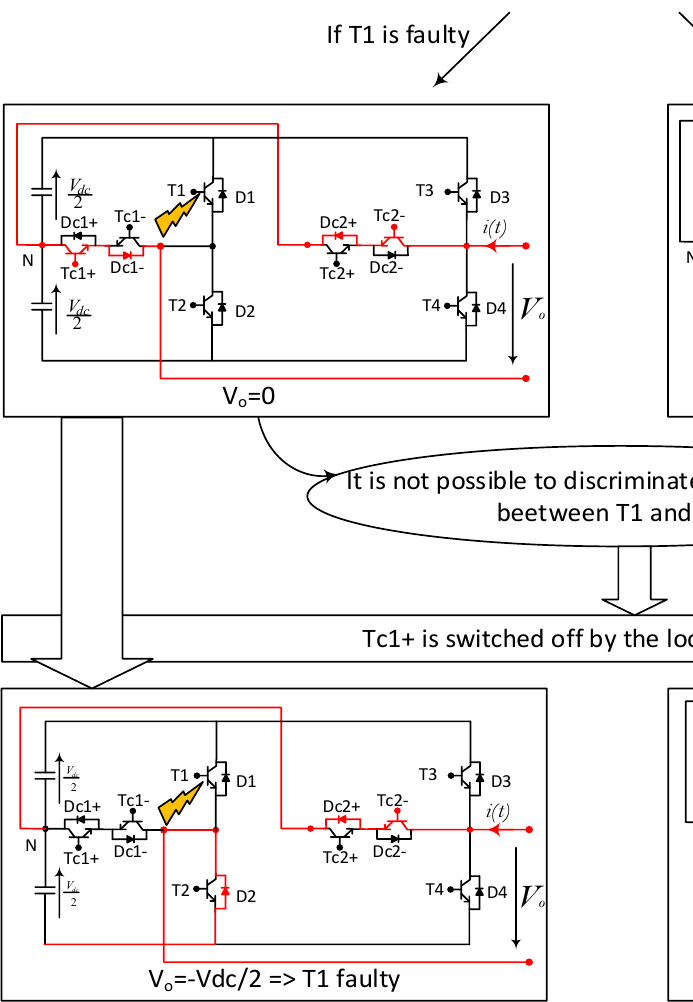
Fig 5. Open switch fault diagnosis in State